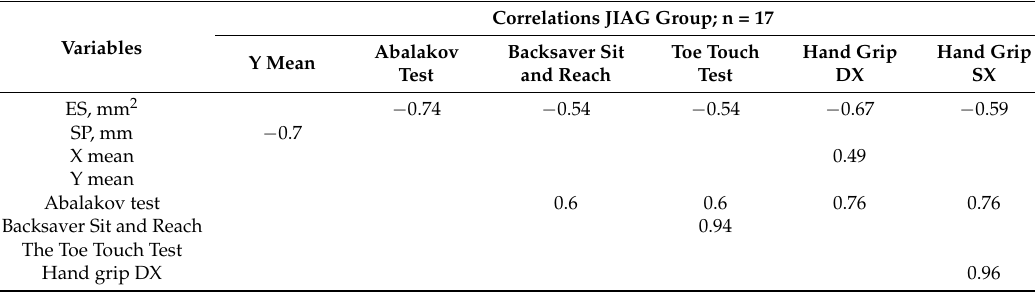
Table 2. Description of the correlations between variables of JIAG groups.